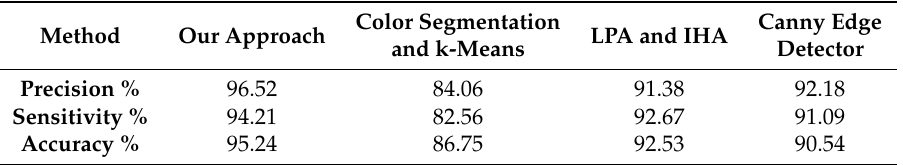
Table 8. Statistical analysis of hot-spot detection